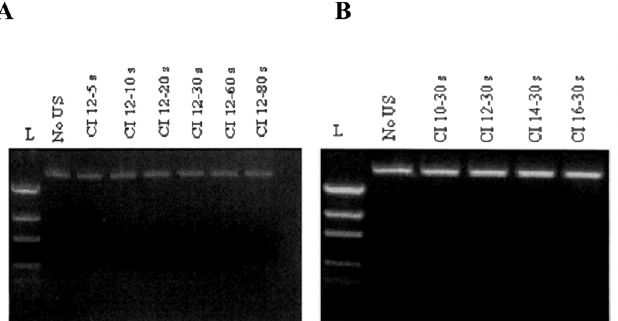
Fig 3. Effect of ultrasound on plasmid integrity. Agarose gel electrophoresis of peGF-C1 plasmid. (A) Ultrasound exposure for 5 – 80 seconds at CI level 12 did not affect plasmid integrity. (B) Plasmid exposure to different CI levels (10, 12, 14 and 16) for 30 seconds did not damage the plasmid integrity. L, Low DNA Ladder (Life Technologies, Rockville, MA, USA). The size and length of bands were the same between exposed and non-exposed plasmids, indicating that ultrasound irradiation does not affect plasmid integrity.